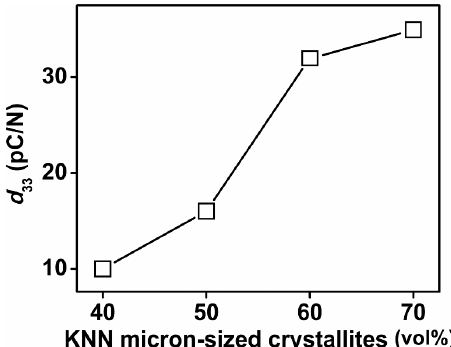
Fig. 8 Variation of the piezoelectric coefficient ( d 33 ) as a function of the volume fraction of KNN crystallites at micron